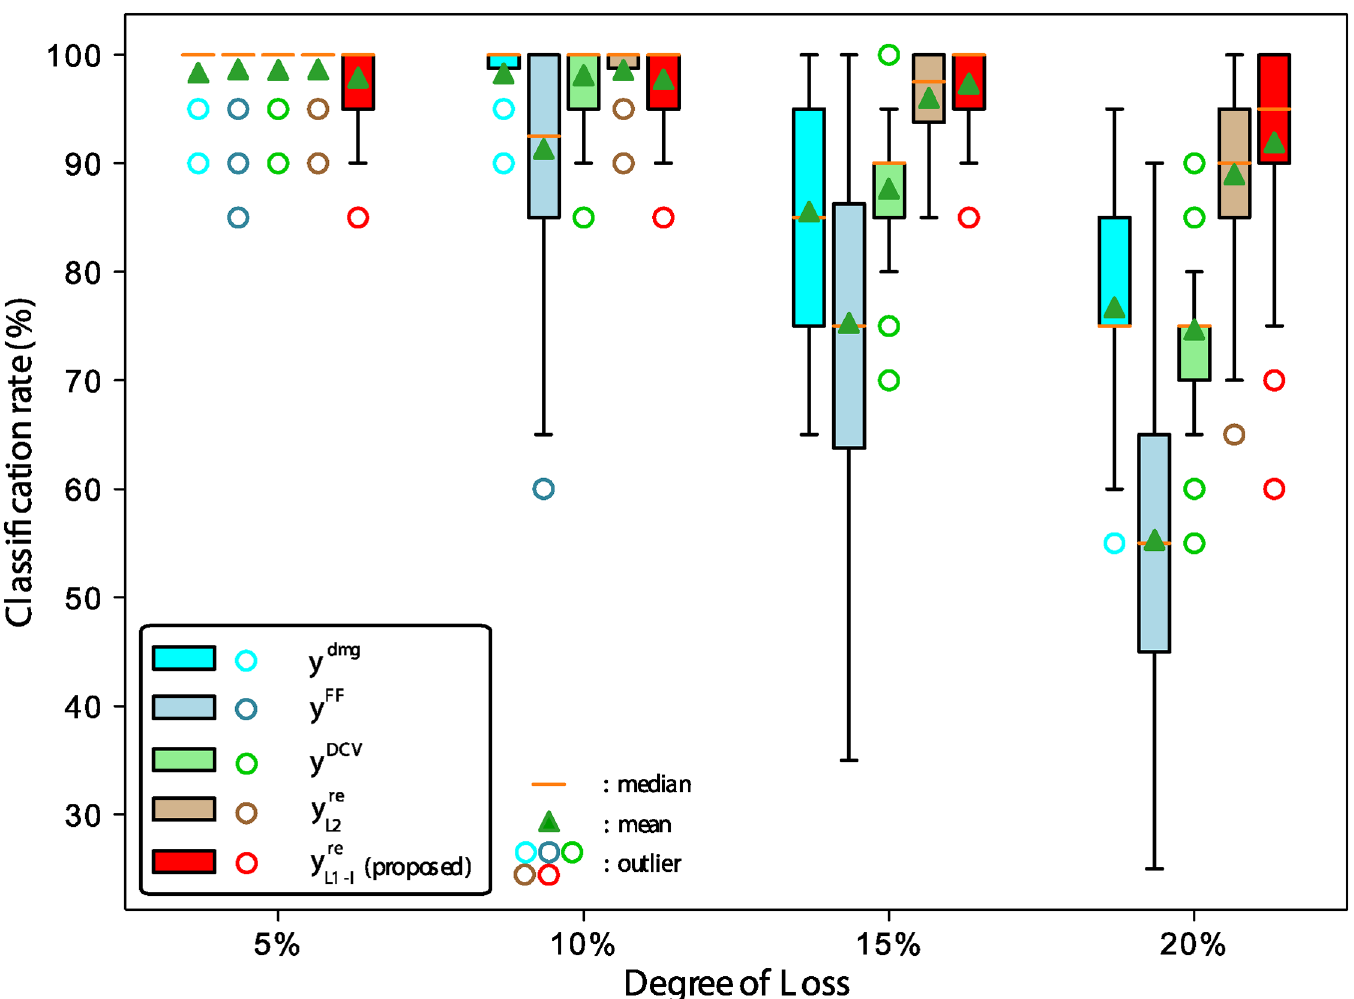
Fig 8. Comparison of classification rates between the proposed method and other